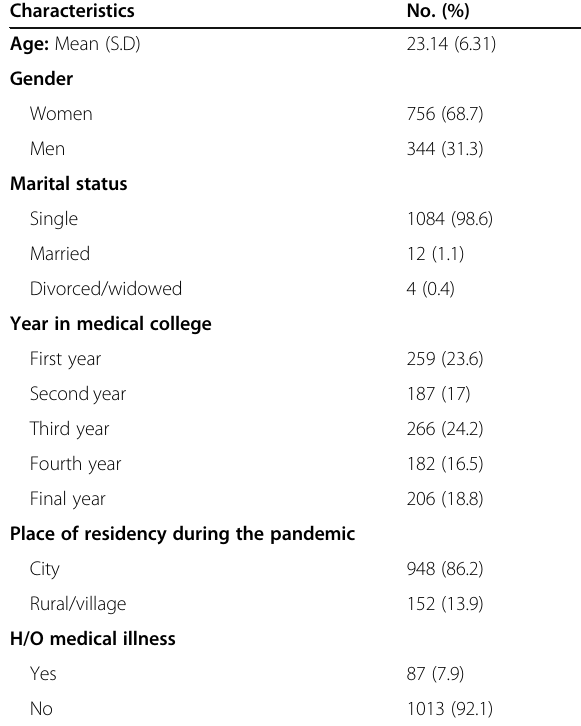
Table 1 Demographic characteristics of respondents ( N = 1100)